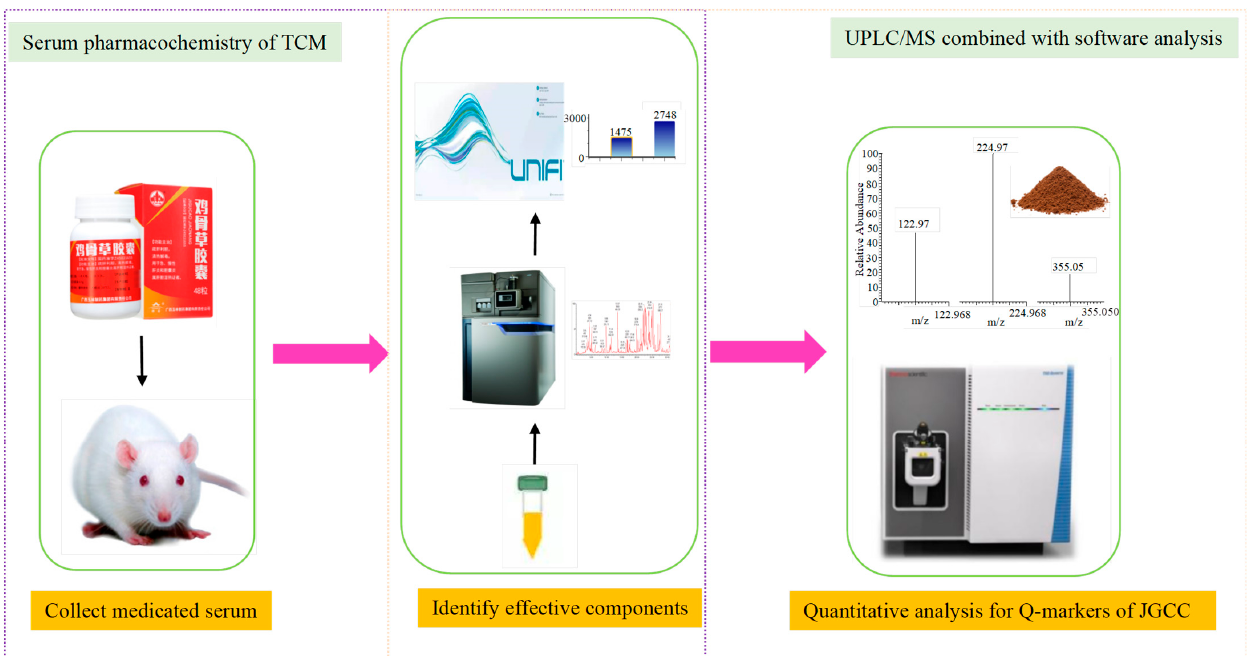
Figure 8. The technical flow chart for the identification of the different components in the blood after ingestion of JGCC and the establishment of the quantitative analysis method in vitro.